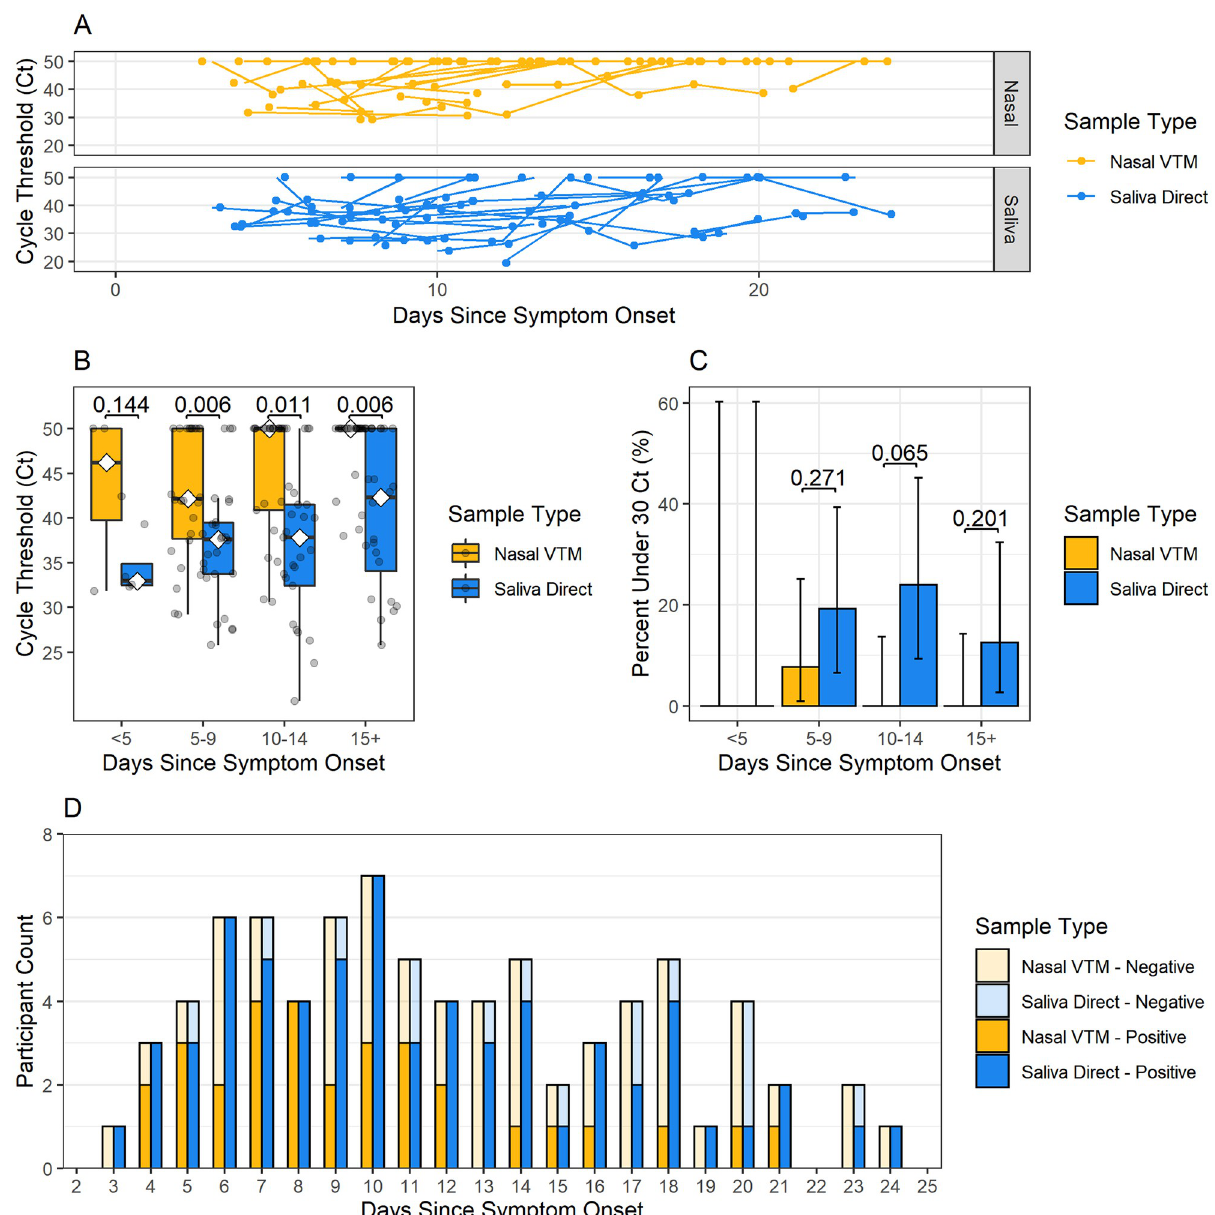
Fig 6. SARS-CoV-2 longevity in longitudinal cohort saliva and nasal specimens. Analysis of paired specimens in the longitudinal analysis cohort (N = 79 paired observations from 28 patients) by (A) Spaghetti plot of longitudinal Ct values for saliva direct and nasal VTM specimens plotted over time in days since symptom onset. Lines indicate specimens from the same patient. (B) Analysis of paired samples in the longitudinal analysis cohort by patient, (B) Ct values, (C) percent of Ct values under 30, and (D) number of positive and negative test results for saliva direct and nasal VTM specimens by days since symptom